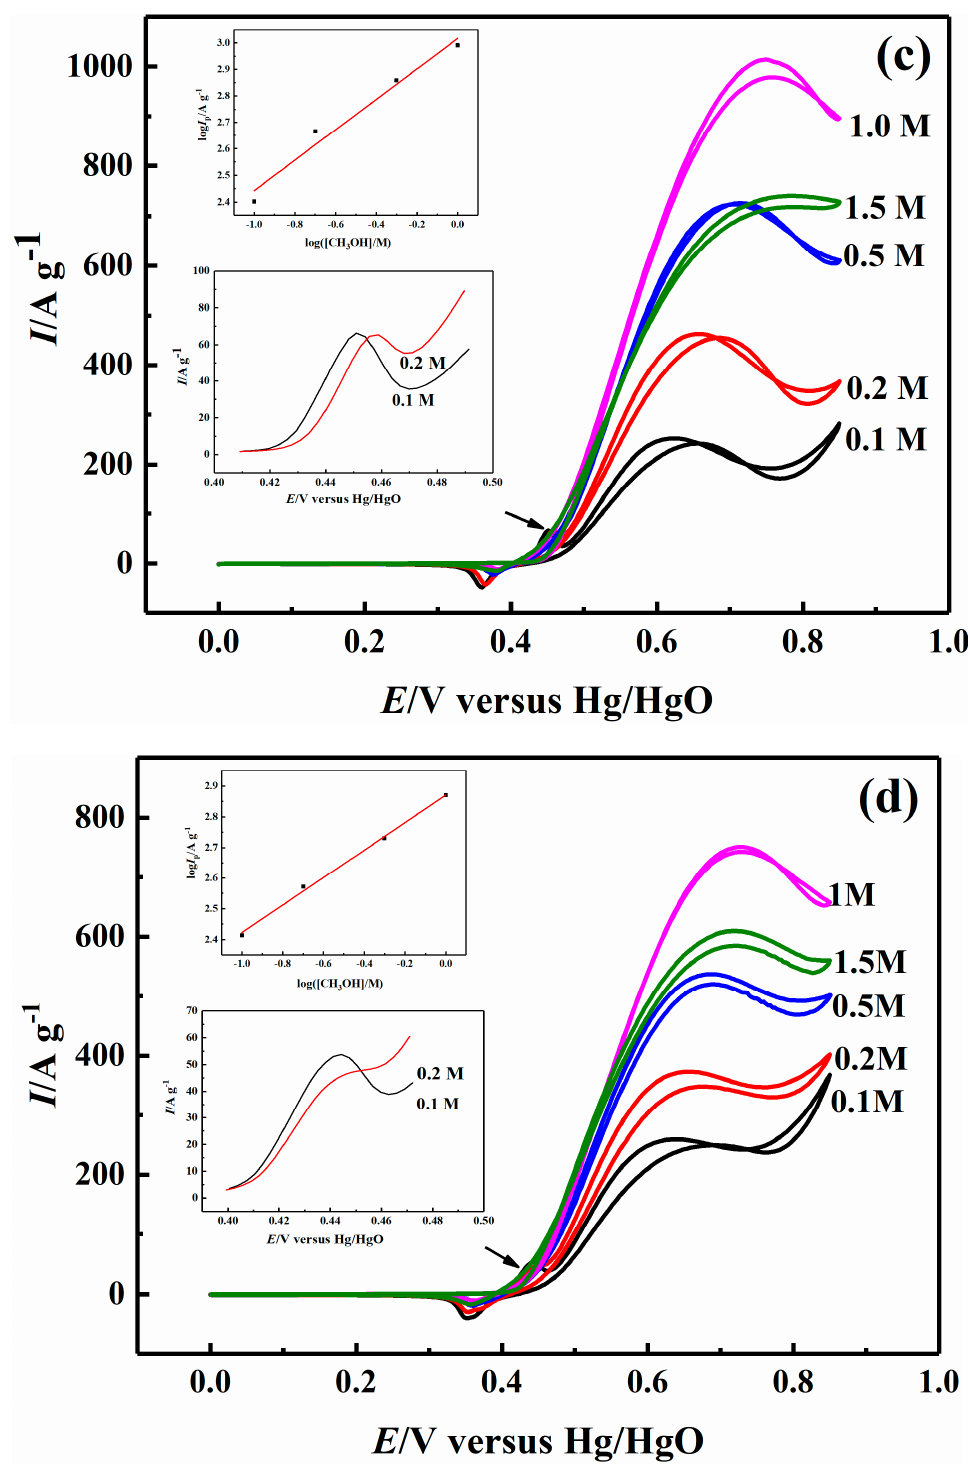
Figure 4. Cyclic voltammograms of the methanol oxidation on Ni-B ( a ), Ni-B-Co 0.02 ( b ), Ni-B-Co 0.05 ( c ), and Ni-B-Co 0.1 ( d ) nanoparticles at potentials ranging from 0 to 0.8 V in 1.0 M NaOH/(0.1–1.5 M) CH 3 OH solutions at a scan rate of 10 mV s − 1 . Insets: Double logarithmic plots of the anodic peak currents for methanol oxidation versus methanol concentrations.